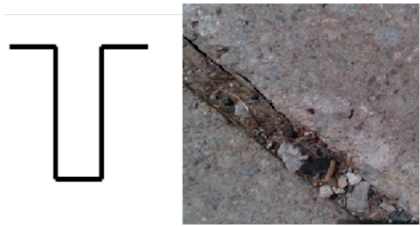
Figure 4. Diagram and an example of a slit.